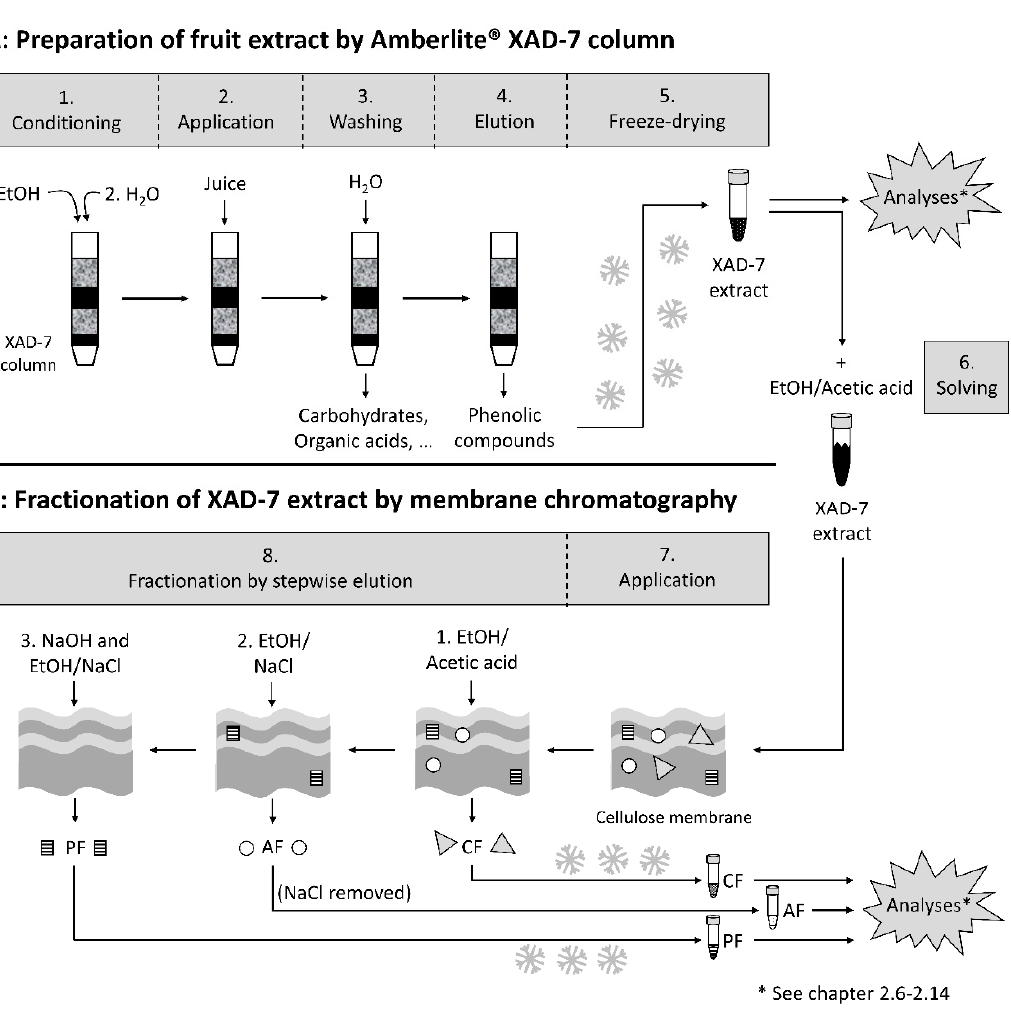
Figure 1. Schematic overview of the preparation of the pomegranate XAD-7 extract ( A ) and its separated fractions ( B ; PF: polymeric fraction; AF: anthocyanin fraction; CF: copigment fraction).